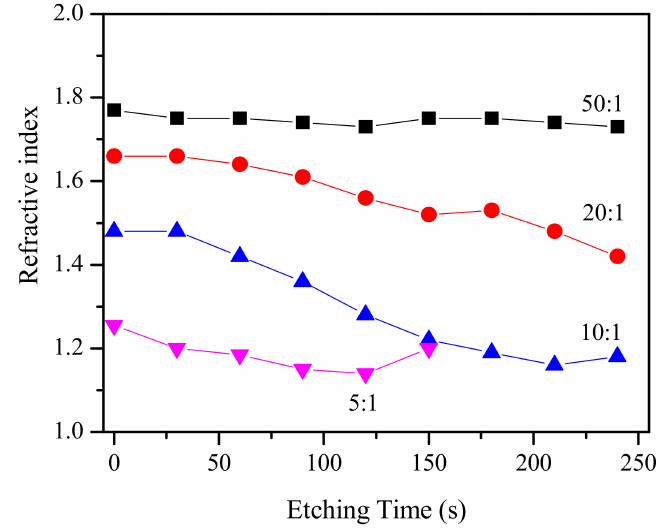
Figure 5. Refractive index change as a function of etching time of porous Nb 2 O 5 layers obtained by liquid phase mixing of niobium sol and colloidal solution of SiO 2 nanoparticles in different volume ratios indicated in the figure. Table 1. Dependence of film thickness, d (nm), and volume fractions of niobia, f niobia , silica, f silica, and air, f air , in hard-templated niobia films after each etching